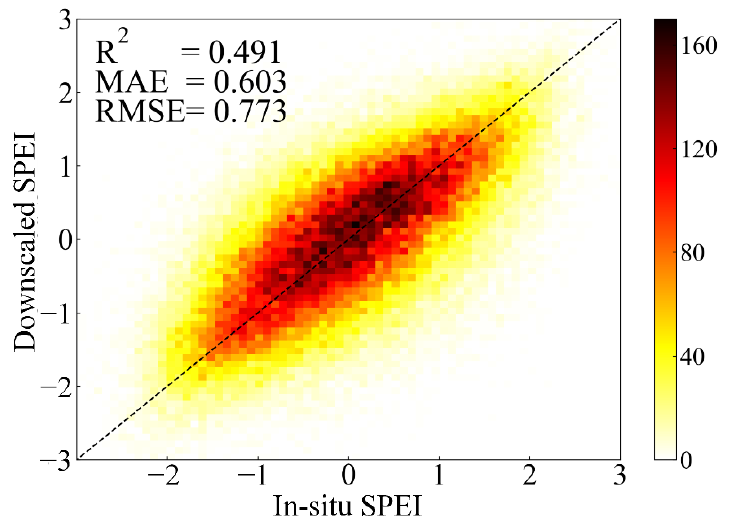
Figure 5. Density scatter plot between estimated and in-situ SPEI.